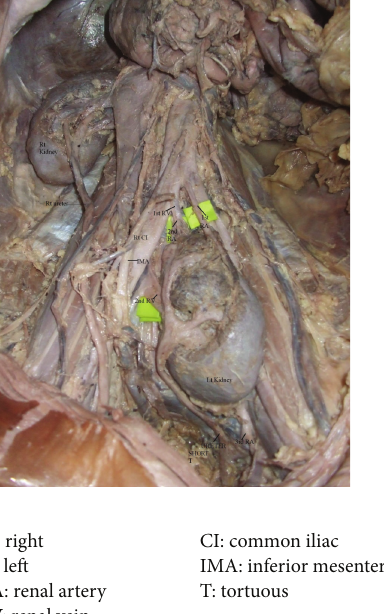
Figure 1: Left kidney pelvic in position, hilum anteriorly placed, open with contents exposed to the surface. Right kidney showing hilum anteriorly placed with bifid renal